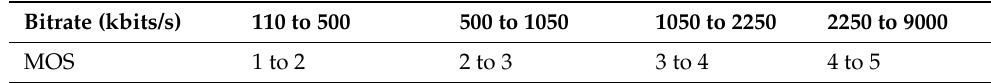
Table 10. HD video MOS versus